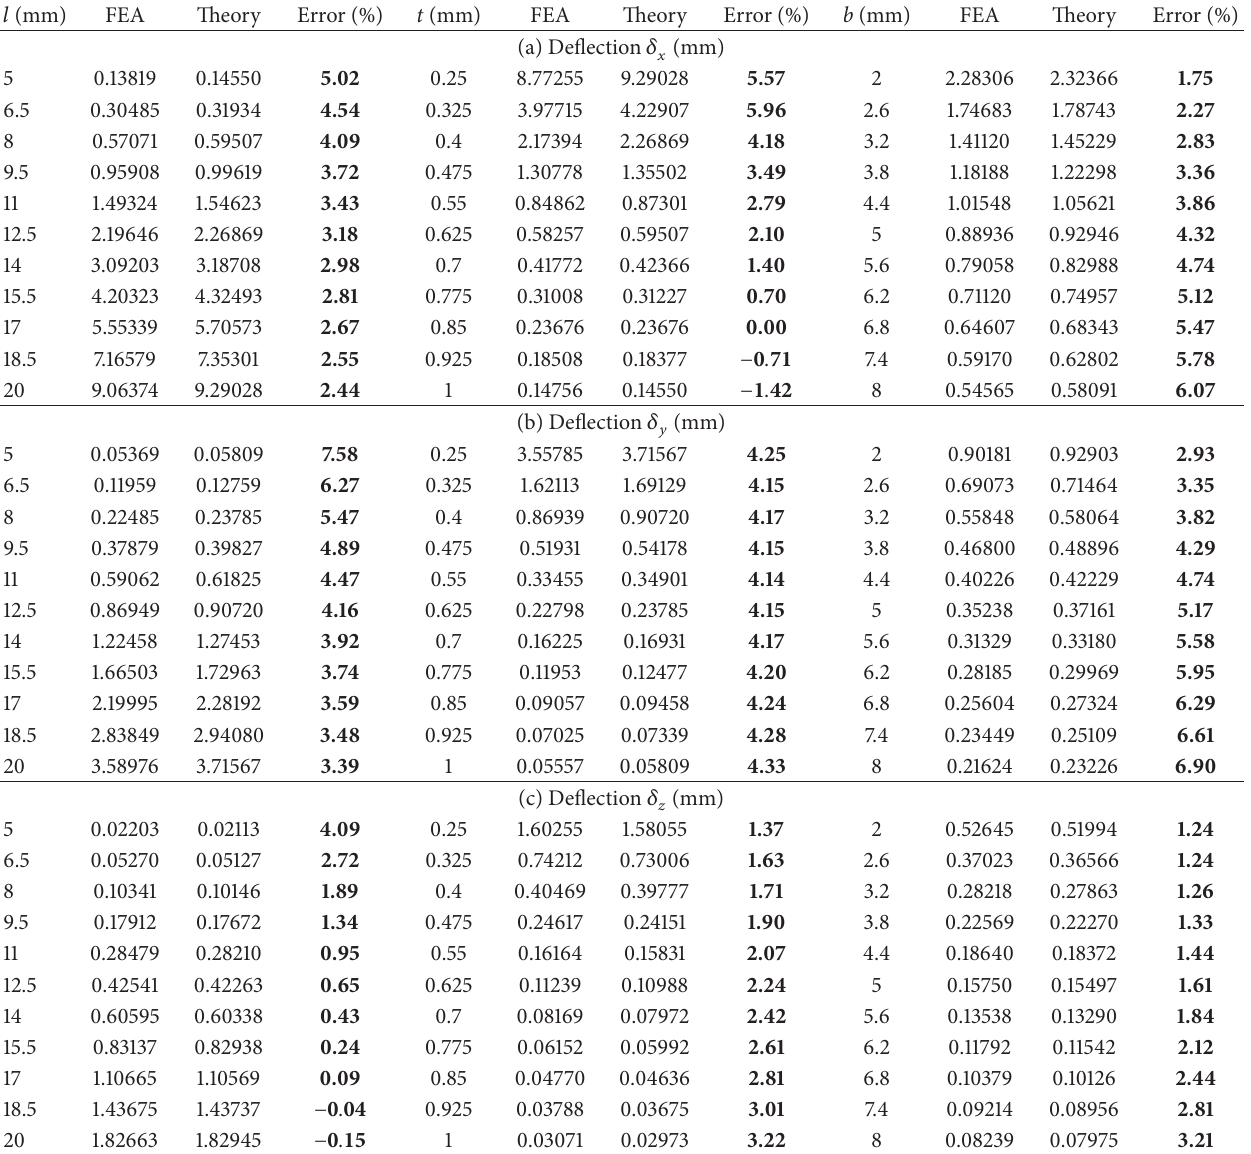
Table 2: Theoretical and FEA results with various lengths 𝑙 , thicknesses 𝑡 , and widths 𝑏 under 𝐹 𝑥 , 𝐹 𝑦 , and 𝐹 𝑧